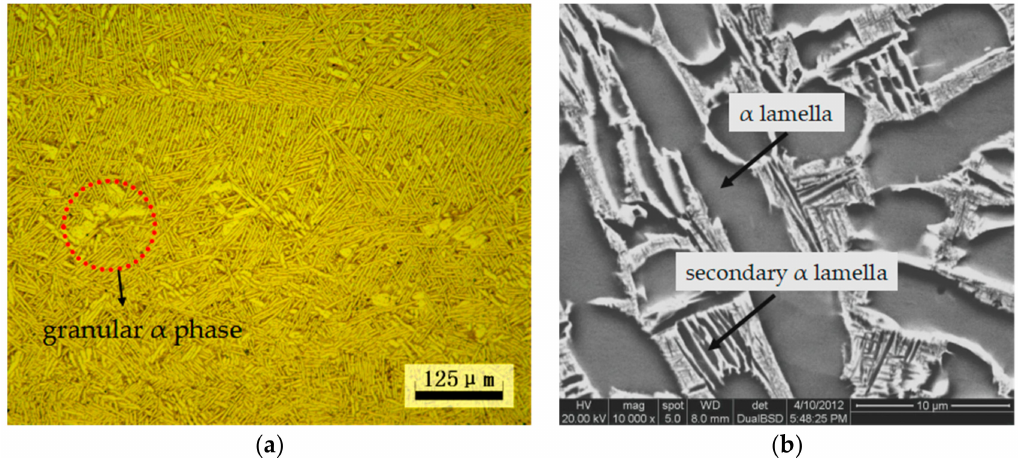
Figure 1. Basketweave microstructure of the TC21 titanium alloy: ( a ) optical micrograph and ( b ) backscattered electron